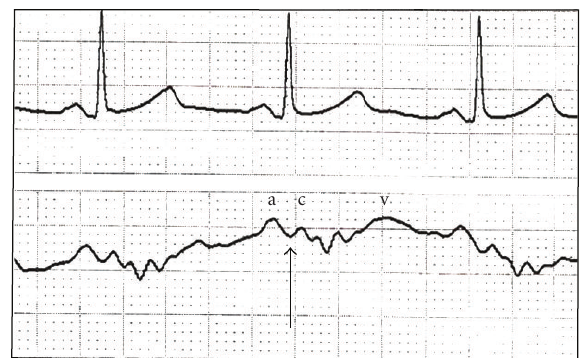
Figure 1: A typical CVP waveform (lower tracing) and accompa- nying electrocardiogram (upper). The a, c, and v waves are shown, along with the z point (arrow), indicating the appropriate time in the cardiac cycle for CVP measurement. All analyses need to occur at end